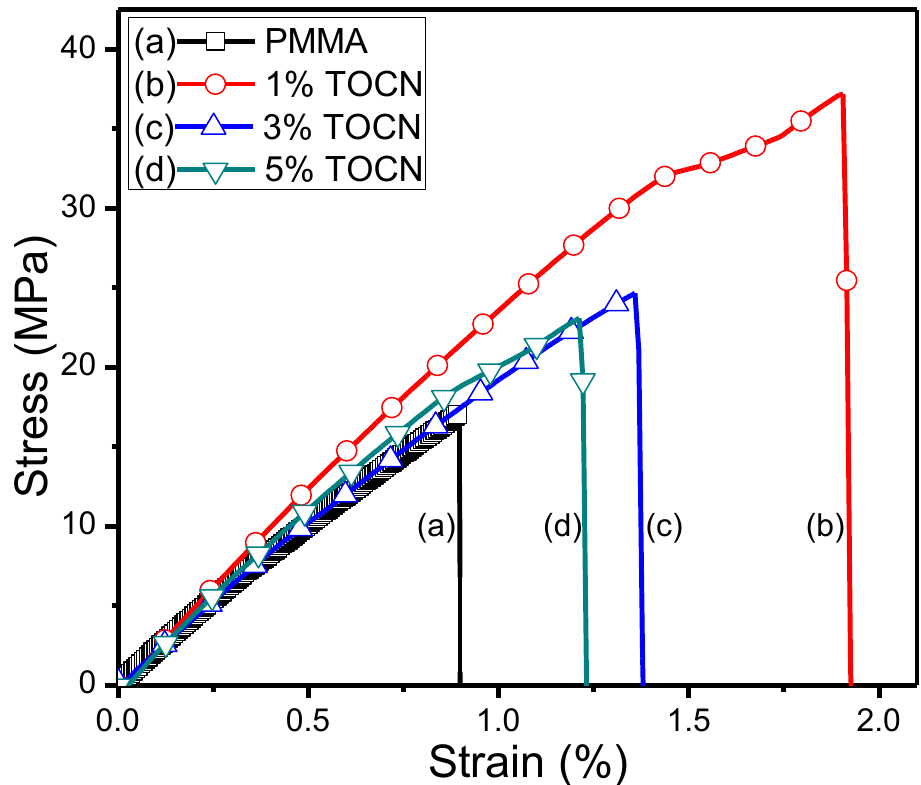
Figure 11. Stress–strain curves of ( a ) PMMA and ( b–d ) composite Figure 11. Stress – strain curves of ( a ) PMMA and ( b – d ) composite species.